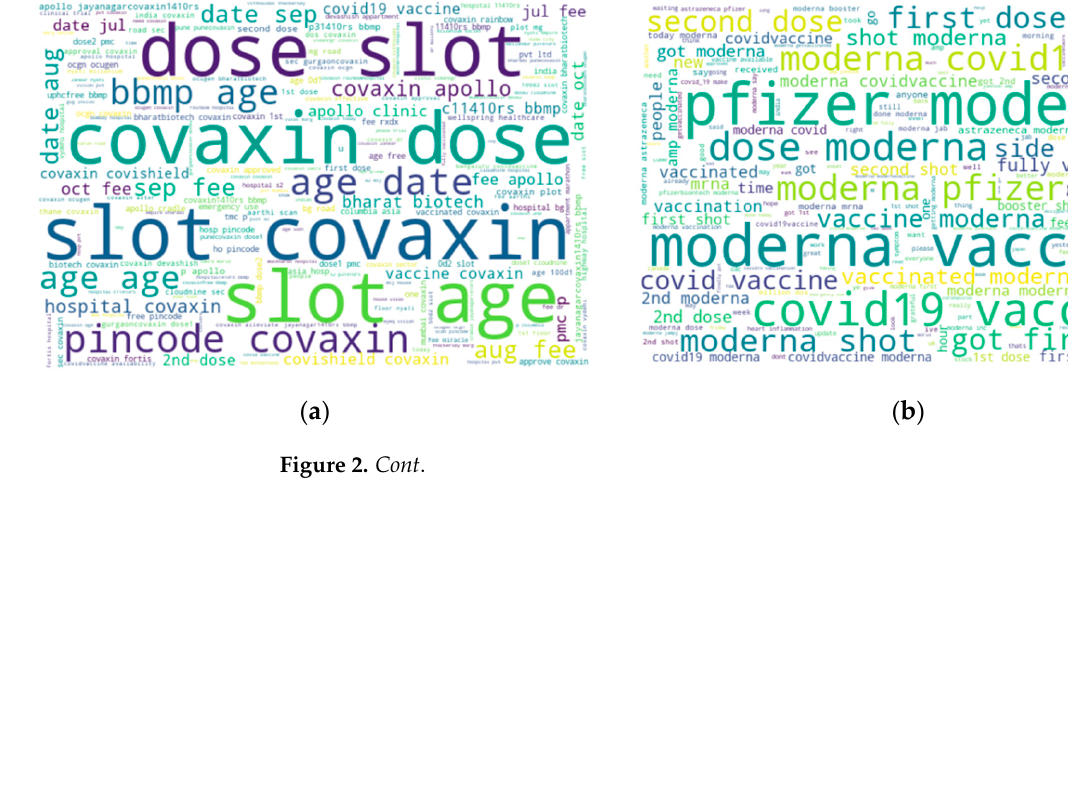
Table 3. Most frequent words in COVID-19 vaccine-related tweets across sentiment types.